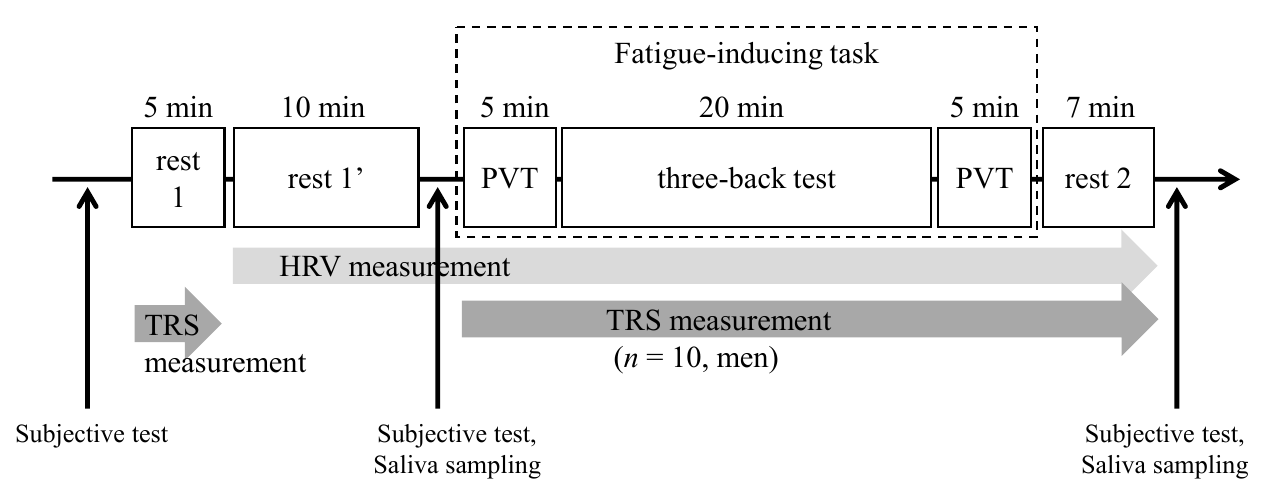
Figure 1. Study protocol. TRS, near-infrared time-resolved spectroscopy; HRV, heart rate variability; PVT, psychomotor vigilance task.